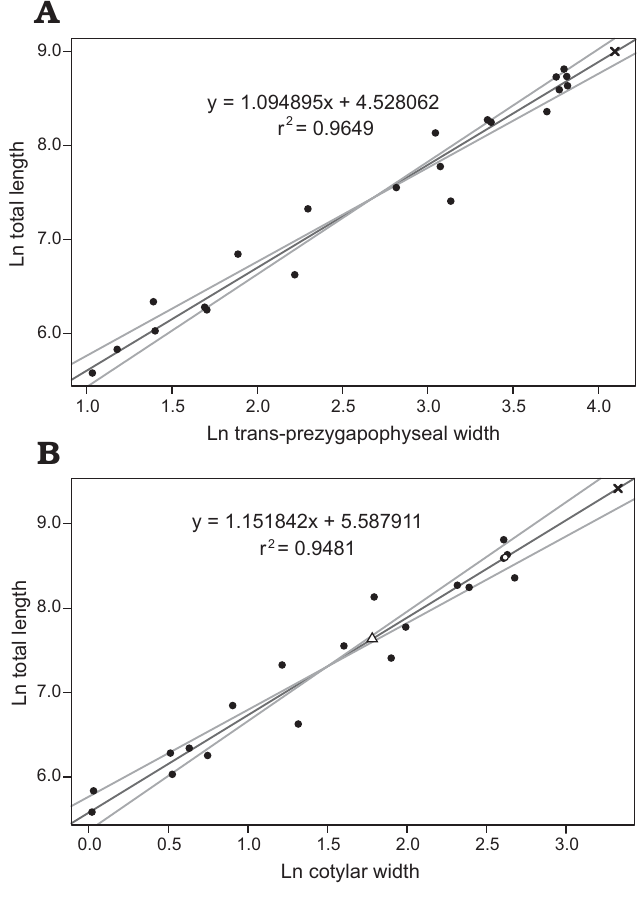
Fig. 8. Standard major axis regressions of vertebral metrics on total length in snakes. A . Regression of the width across the prezygapophyses on to- tal length. Palaeophis colossaeus (CNRST-SUNY 290) is plotted as an × B . Regression of the width of the cotyle on total length. Palaeophis colos- saeus (CNRST-SUNY 290) is plotted as an ×, Amananulam sanogoi gen. et sp. nov. (CNRST-SUNY 426) as an open triangle, and indeterminate snake CNRST-SUNY 324 as an open circle. Width across prezygapophy- ses is unavailable in the latter species due to Table 1. Measurements of fossil snakes from the Trans-Saharan Sea- way in Mali. Estimated total length based on linear regression of ver- tebral measurements.